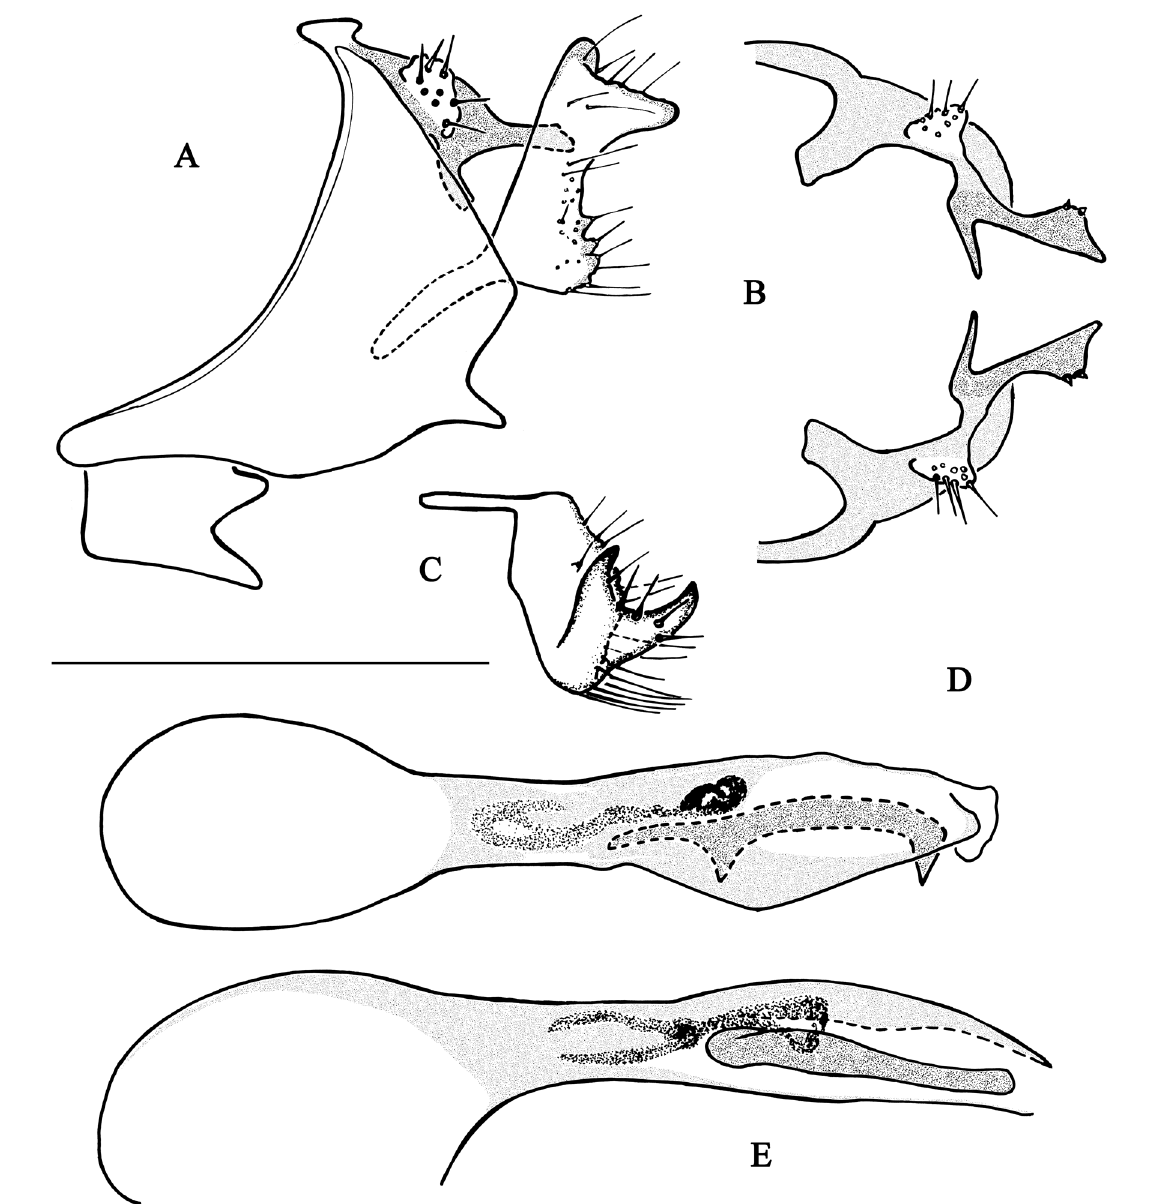
Fig. 11. Chimarra makiorum sp. nov. A–B . Abdominal segments IX and X. A . Lateral view with ventral margin of sternite VIII. B . Dorsal view (partim) . C . Inferior appendage, dorsal view. D–E . Phallic apparatus. D . Dorsal view. E . Lateral view. Scale bar =